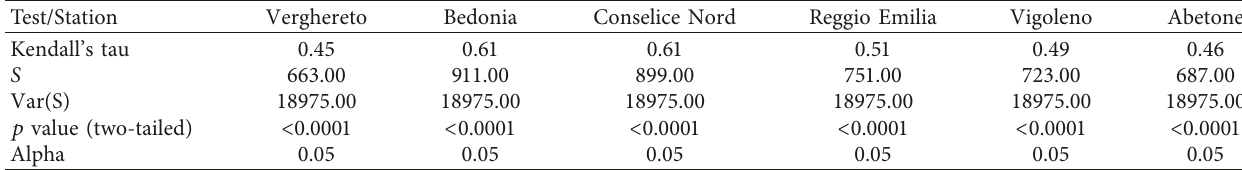
Table 2: The Mann-Kendall trend test statistic applied for annual maximum temperature